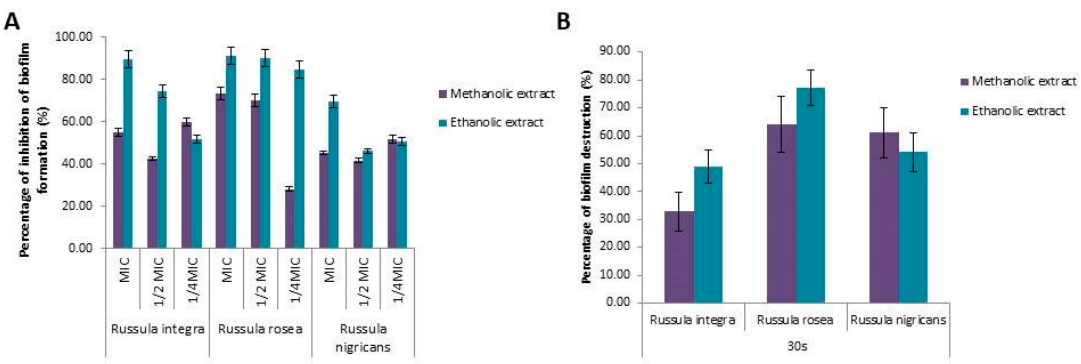
Figure 1. ( A ) Inhibition of S. aureus biofilm formation after treatment with MICs and subMICs of R. integra , R. rosea , and R. nigricans extracts. ( B ) Destruction of S. aureus 24 h preformed biofilm after 30 s treatment with MBC of R. integra , R. rosea , and R. nigricans extracts. Results are expressed as inhibition percentage, average value of three replicates ± SD.